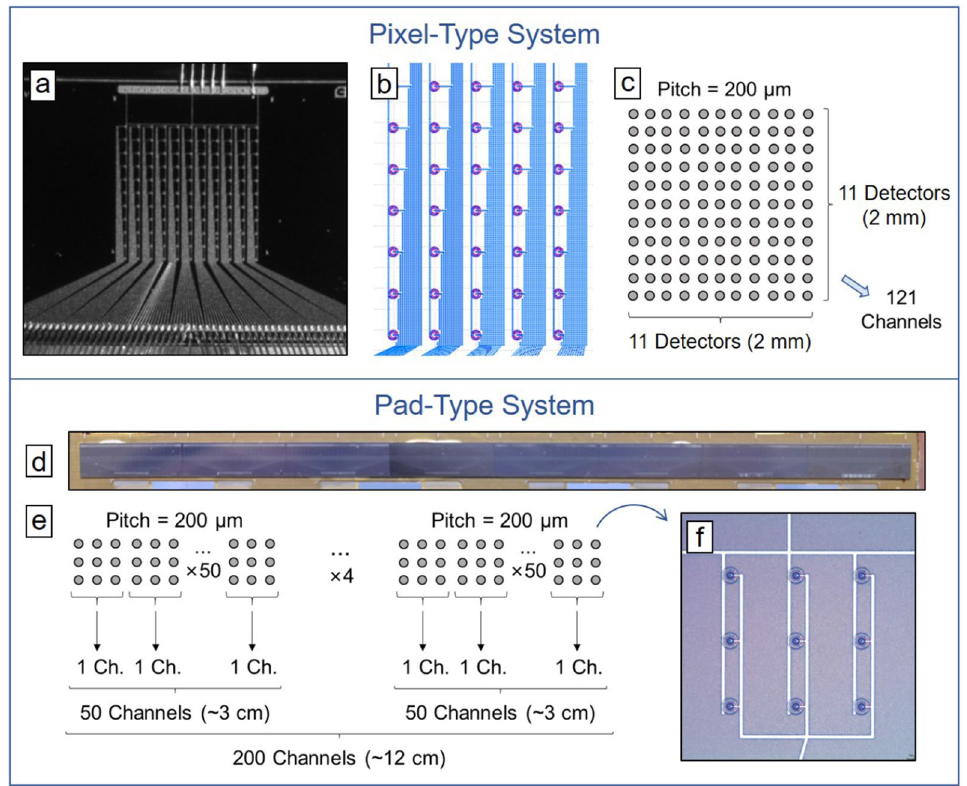
Figure 2. ( a ) Optical image of the 11 connected to a ROC channel. ( c ) Sketch of the pixel-type array. ( d ) Photograph of the eight pad-type arrays stacked laterally covering a 12 cm length. ( e ) Sketch of the pad-type array. ( f ) Optical image of one of the 3